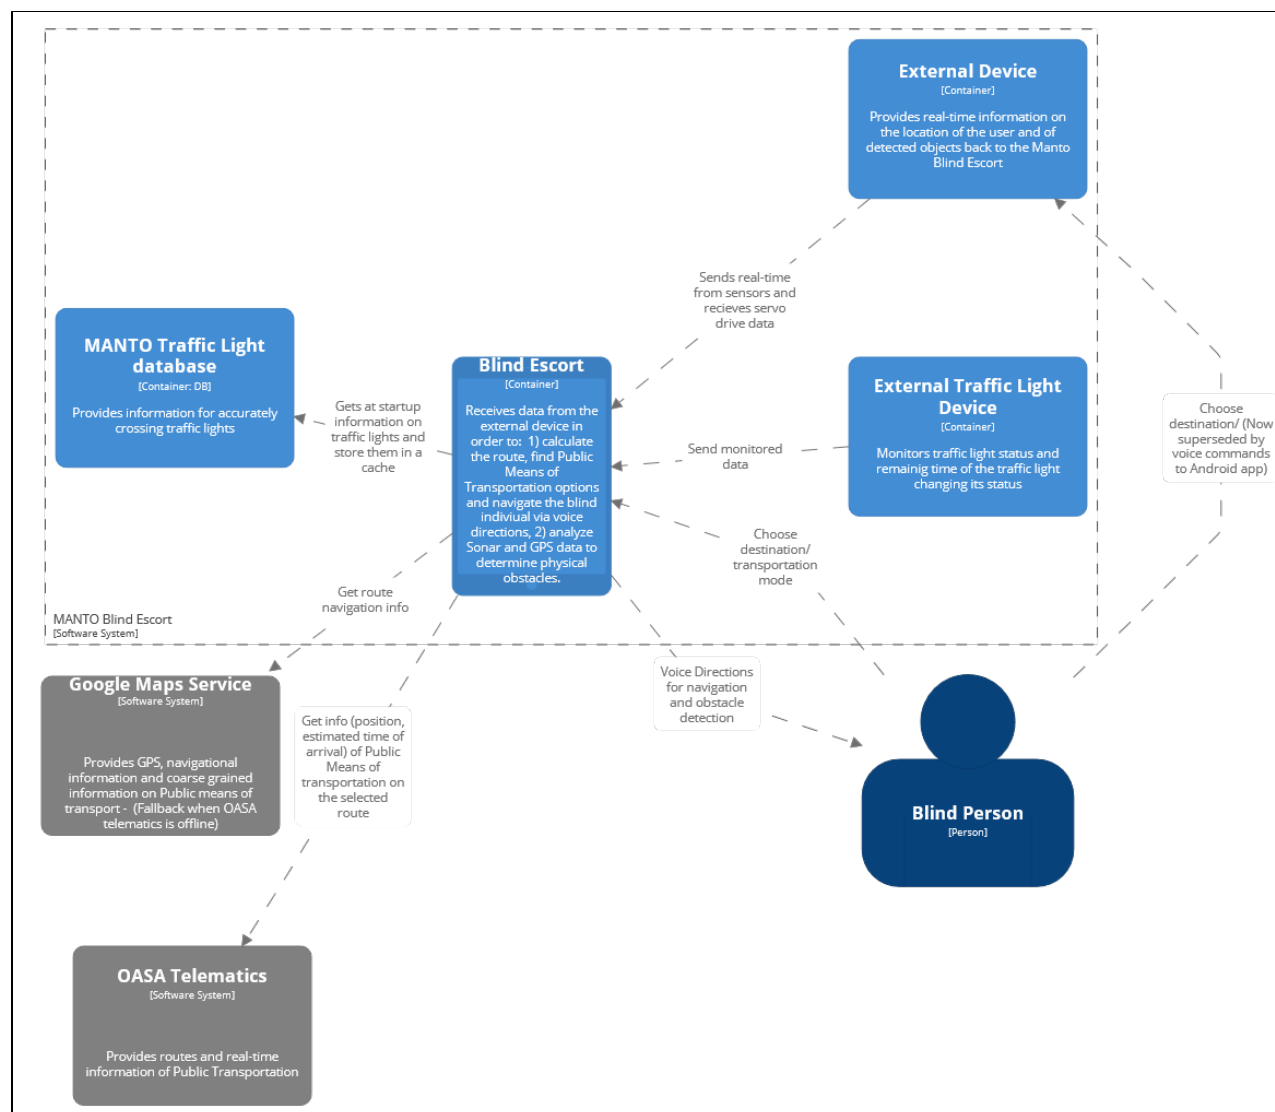
Figure 1. Architectural diagram of the application.